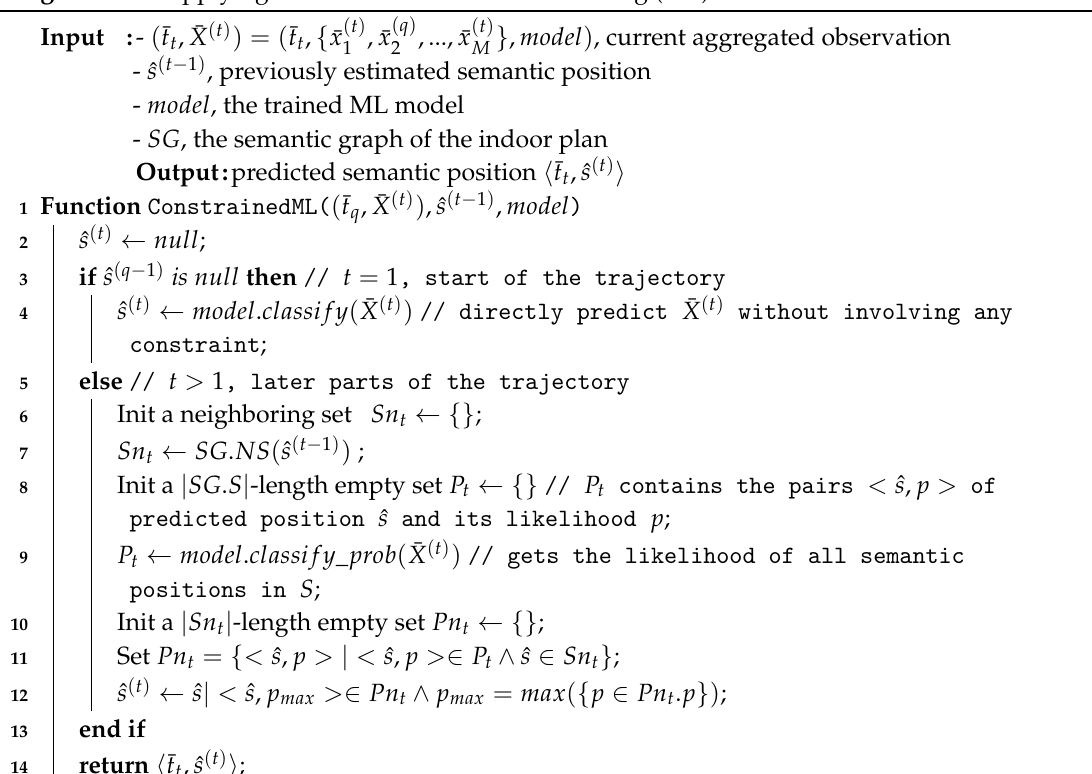
Algorithm 4: Applying a constraint to a machine learning (ML) classification